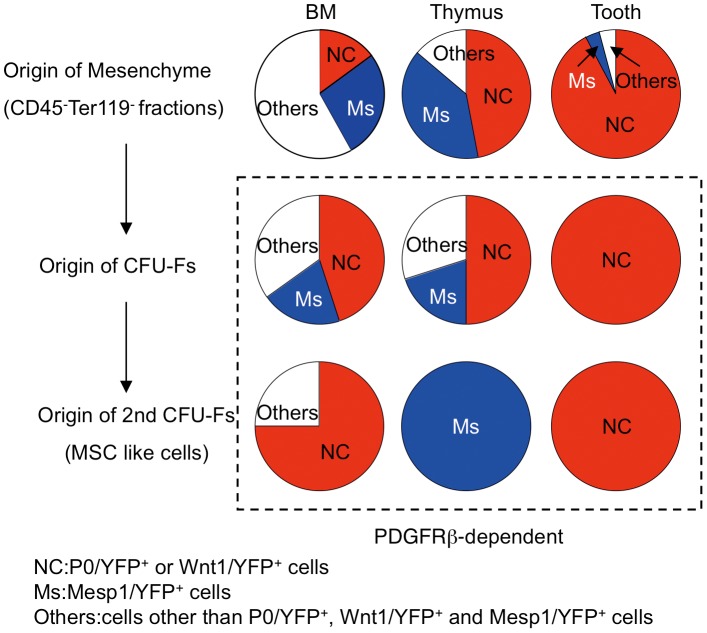
Origin and properties of dental, thymic, and BM mesenchymal cells and their CFU-Fs.Percentages of NC-derived and mesoderm-derived cells comprising BM, thymic, and dental mesenchyme (CD45− and Ter119− cells). YFP+ cells in CD45− and Ter119− cells from P0-Cre/YFP and Wnt1-Cre/YFP mice represent NC-derived cells (NC). YFP+ cells in CD45− and Ter119− cells from Mesp1-Cre/YFP mice represent mesoderm-derived cells (Ms). YFP− cells other than YFP+ cells in the CD45− and Ter119− cells from P0-Cre/YFP (Wnt1-Cre/YFP) and Mesp1-Cre/YFP mice represent others. The expression of primary and secondary CFU-Fs in vitro was dramatically affected by PDGFRβ inhibition, irrespective of tissue and origin.